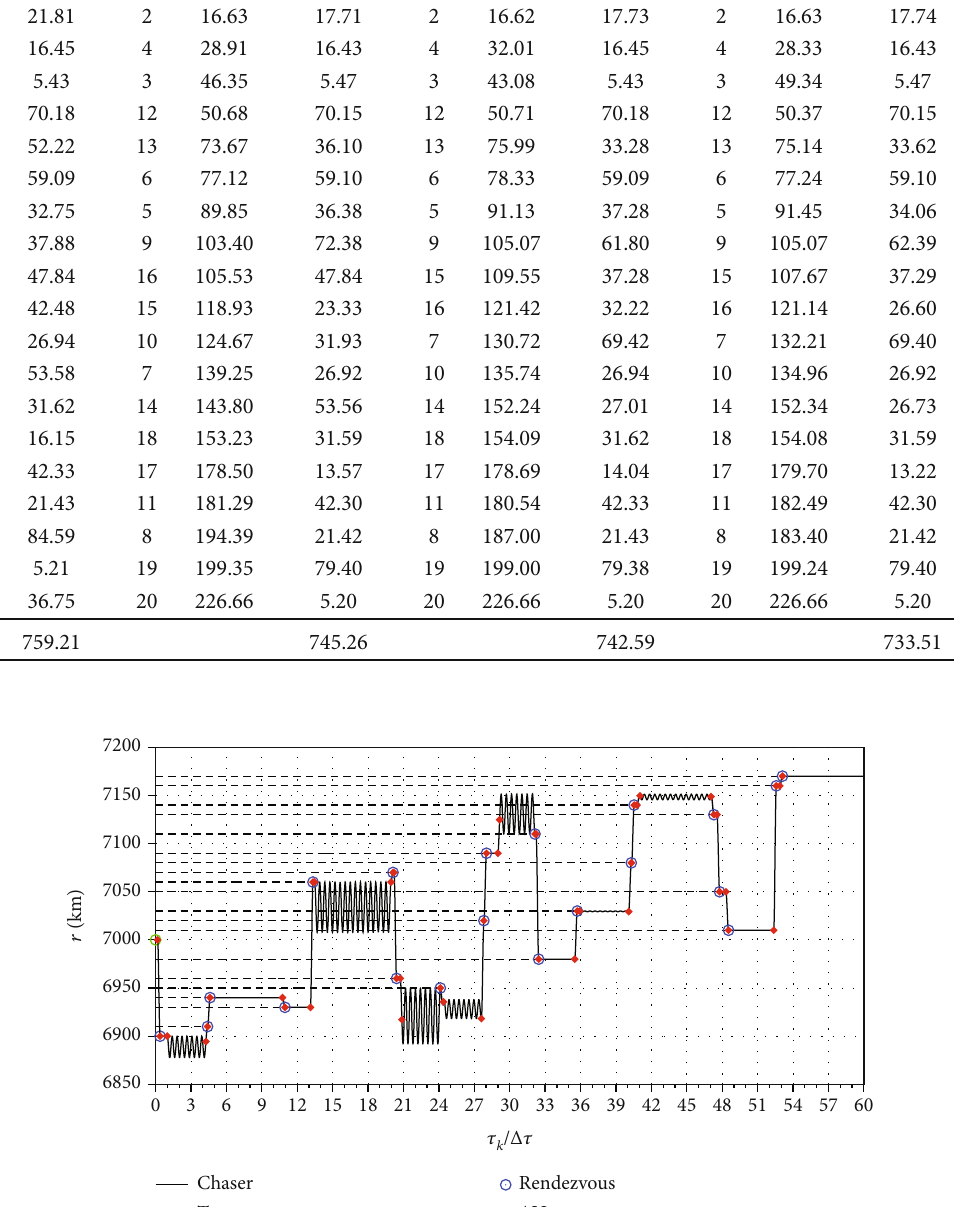
Figure 12: Chaser radius r as a function of nondimensional time τ